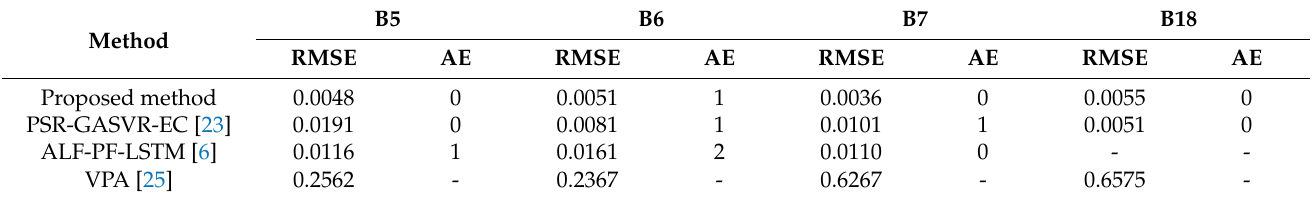
Table 5. A comparison of the prediction performance with the existing results.